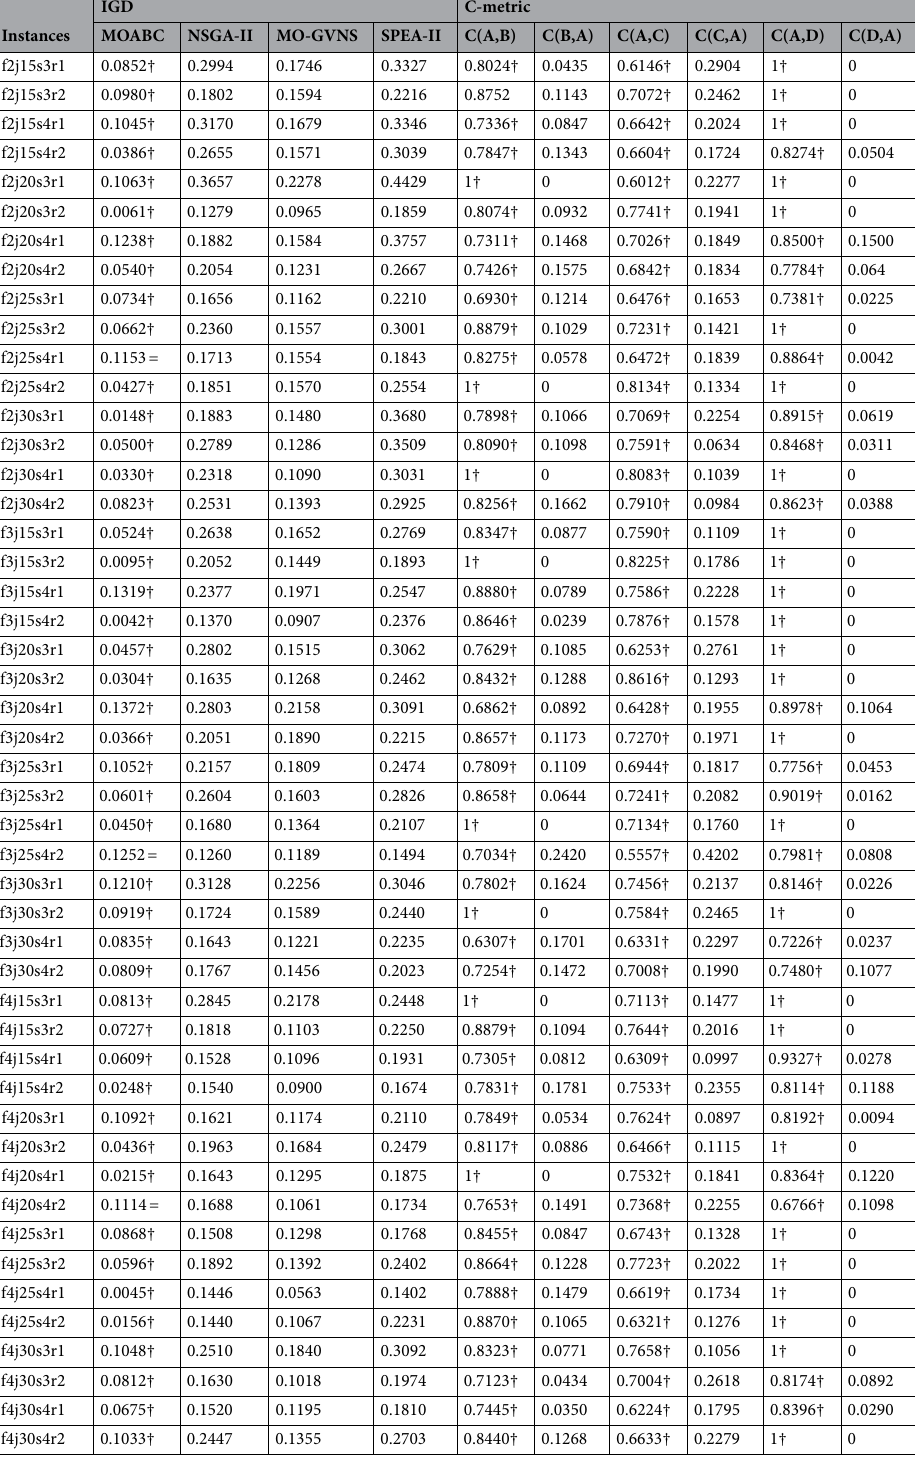
Table 10. IGD and C-metric metrics of four algorithms (A: MOABC, B: NSGA-II, C: MO-GVNS, D: